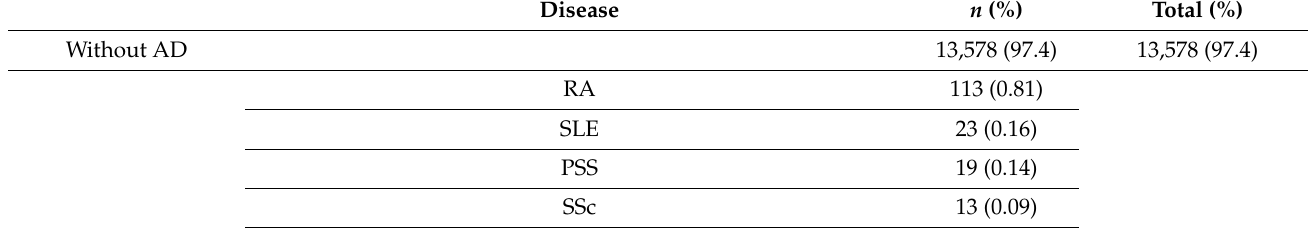
Table 1. Classification of the autoimmune diseases